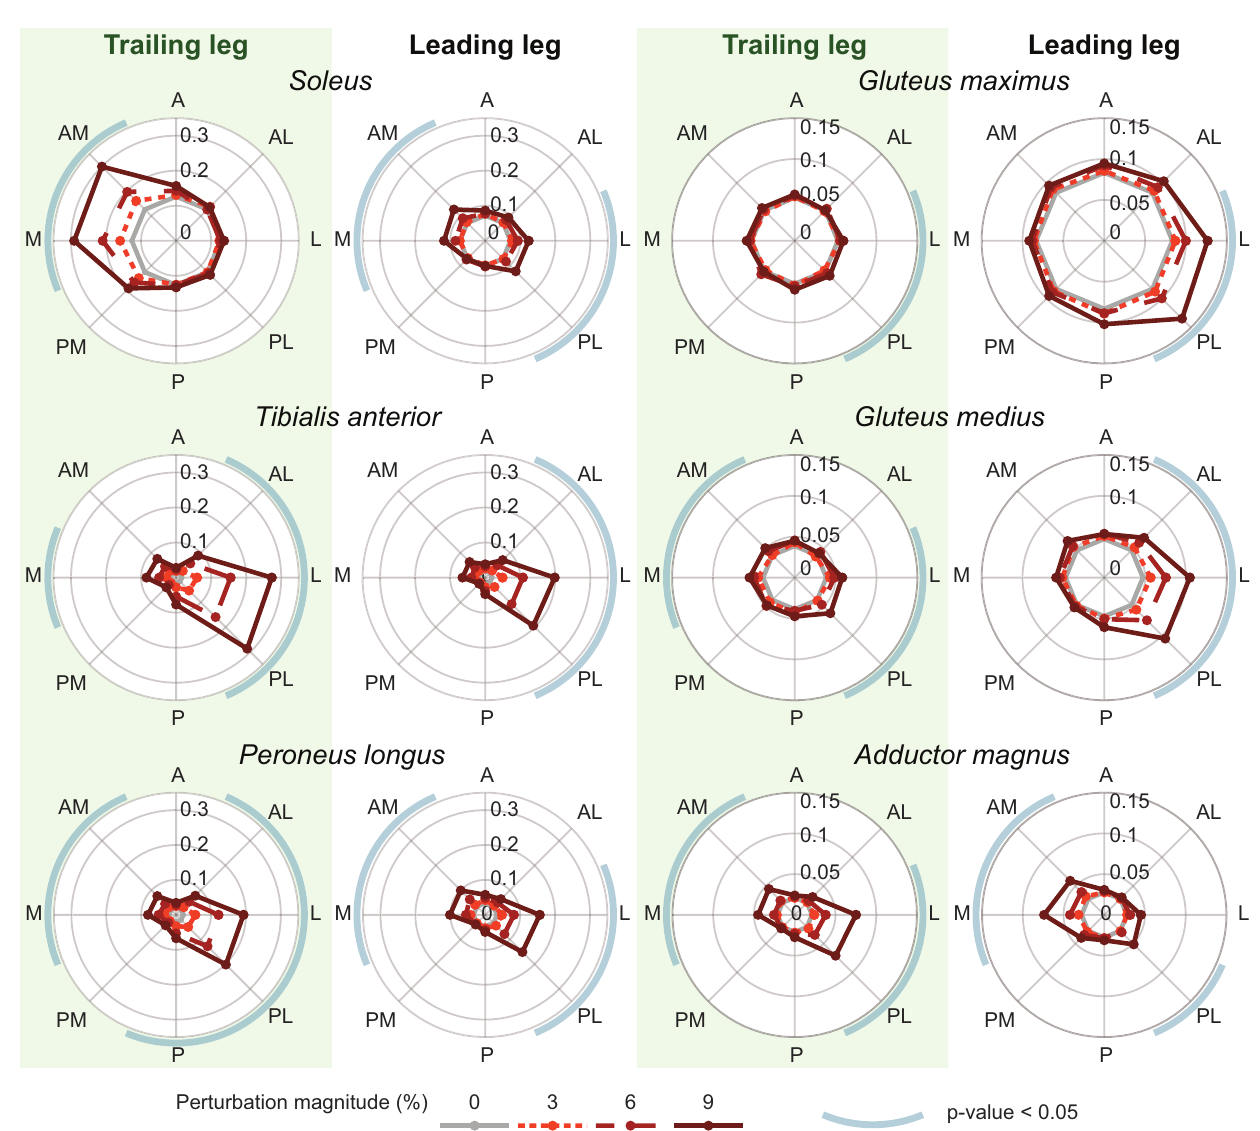
Fig 4. Normalised muscle activity. Muscle activations over the first 1.5 s after the perturbations given in the different directions. The results are presented for the trailing (= left) leg and leading (= right) leg. The line colour and style indicate the perturbation magnitudes. The blue circular arcs around the polar plots indicate whether there is a significant effect of the perturbation on the outcome measure with p < 0.05. All results are based on the averages across all